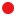
Neighbor-Joining rooted phylogenetic tree of partial HBV S-gene (231–801 nt) sequences from 85 Ethiopian isolates start with ETHAW and marked by red-dot (●) and 71 reference sequences retrieved from GenBank with accession number followed by respective HBV genotype A to H.The numbers at the nodes indicate percentage of bootstrapping values.